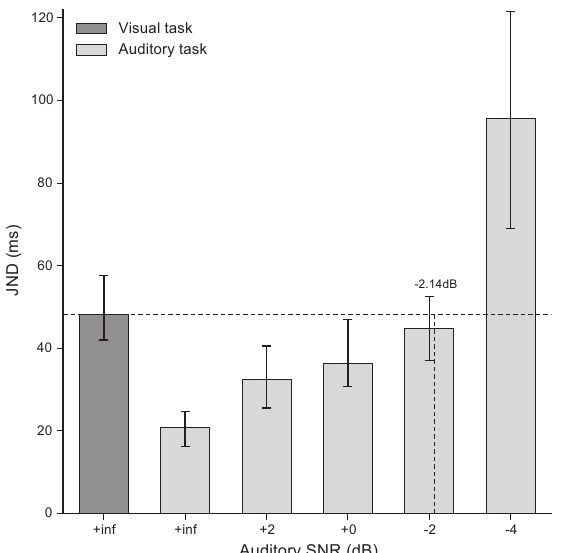
Fig 5. Results of Experiment 3. Average visual sensitivity JND V (dark gray bar) and auditory sensitivities JND A accordingto the signal-to-noise ratio (light gray bars). Error bars indicatethe 95% confidenceintervals. For each subject, the SNR that raises JND A to the level of JND V was determined using linear interpolation betweenthe first successiveSNR pair for which the JND A segment containedJND V (horizontal dashedline). As an example,the group SNR of –2.14dB was found in the [–2dB, –4dB] segment.